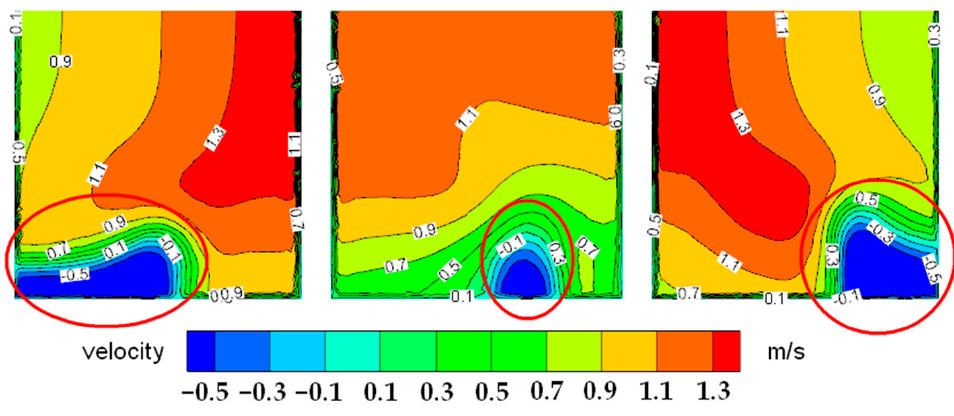
Figure 14. Contour map of the inlet section velocity in the original scheme 0. The normal velocity uniformity V an and the normal weighted average angle θ